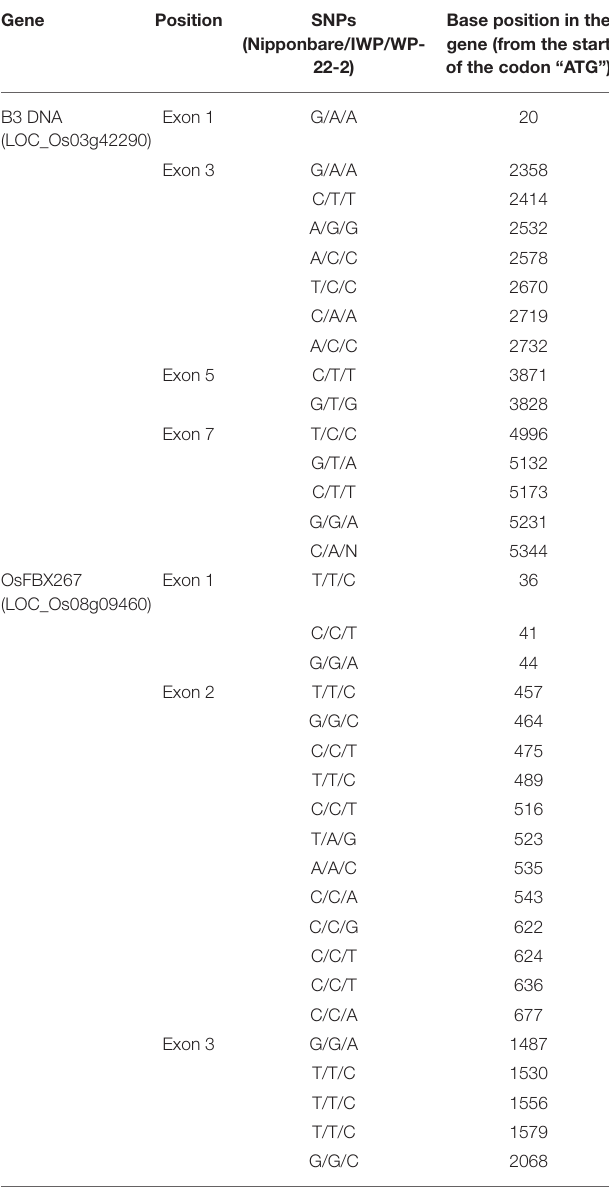
TABLE 2 | Single nucleotide polymorphisms (SNPs) observed in the B3 DNA and OsFBX267 gene coding regions of Nipponbare, IWP, and WP-22-2 genotypes. Gene Position SNPs Base position in the (Nipponbare/IWP/WP- gene (from the start 22-2) of the codon “ATG”) B3 DNA Exon 1 (LOC_Os03g42290)